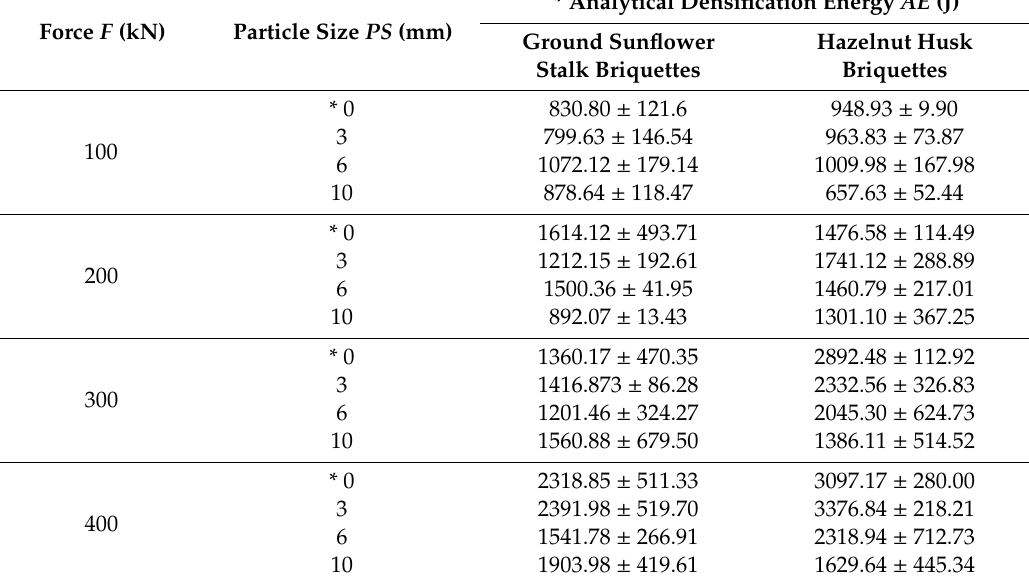
Table 13. Analytical densification energy of ground sunflower stalks and hazelnut husks at moisture contents of 11.23% and 12.64% w.b.